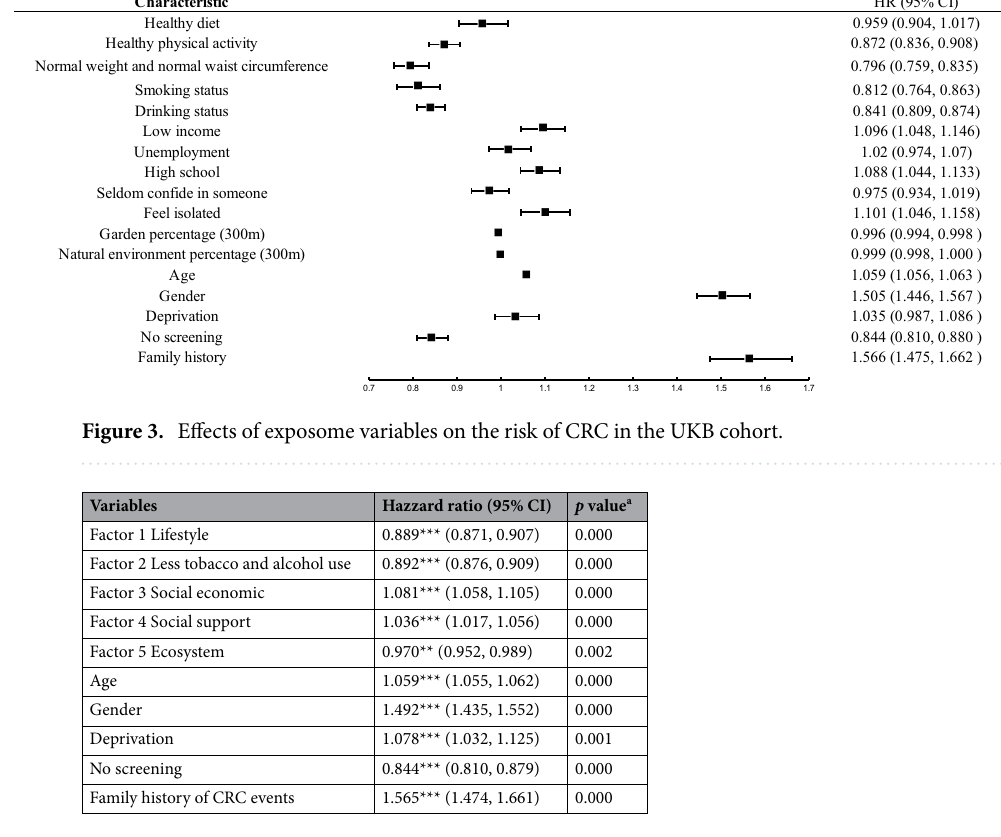
Table 3. Multivariable-adjusted hazard ratio (95% CI) of CRC events by exposome factors among 335,370 participants. a p < 0.05*; p < 0.01**; p <